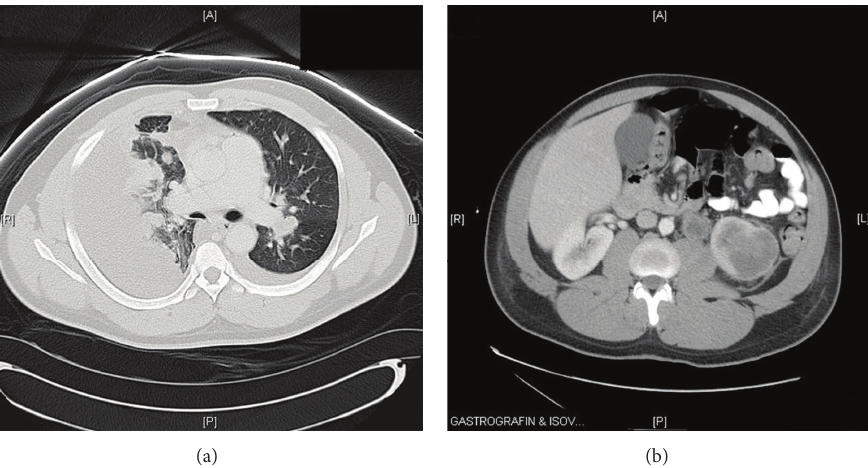
Figure1:(a)CTscanofthechestinlungwindowsshowslargerightpleuraleffusion,smallleftpleuraleffusion,andmultiplepulmonarynodu- les and masses. (b) CT scan of the abdomen shows irregular left lower pole low attenuation cystic renal mass with adjacent lymphadenopathy.